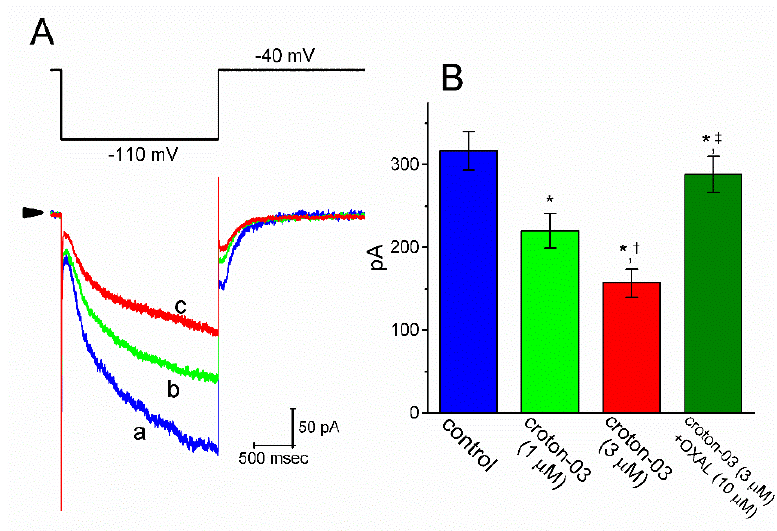
Figure 7. Inhibitory action of croton-03 on I h identified in INS-1 cells. This set of experiments was conducted in cells bathed in Ca 2 + -free, Tyrode’s solution and the recording pipette was filled with K + -containing solution. ( A ) Representative I h traces obtained in the absence (a) and presence of 1 µ M croton-03 (b) or 3 µ M croton-03 (c). The upper part indicates the voltage protocol applied. ( B ) Summary bar graph showing the e ff ect of croton-03 and croton-03 plus oxaliplatin on I h amplitude (mean ± SEM; n = 7–8 for each bar). Current amplitude was obtained at the end of 2-sec hyperpolarizing pulse from − 10 to − 110 mV. OXAL: 10 µ M oxaliplatin. * Significantly di ff erent from control ( p < 0.05), † significantly di ff erent from croton-03 (1 µ M) along group ( p < 0.05), and ‡ significantly di ff erent from croton-03 (3 µ M) along group ( p < 0.05).